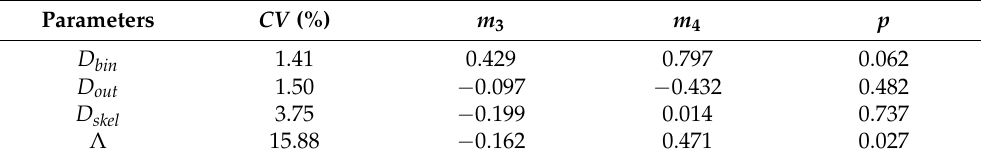
Table 2. The coefficient of variation ( CV ), skewness ( m 3 ), kurtosis ( m 4 ), and p -value of the Shapiro- Wilk test of four parameters ( D bin , D out , D skel and Λ ) were calculated for the present sample.